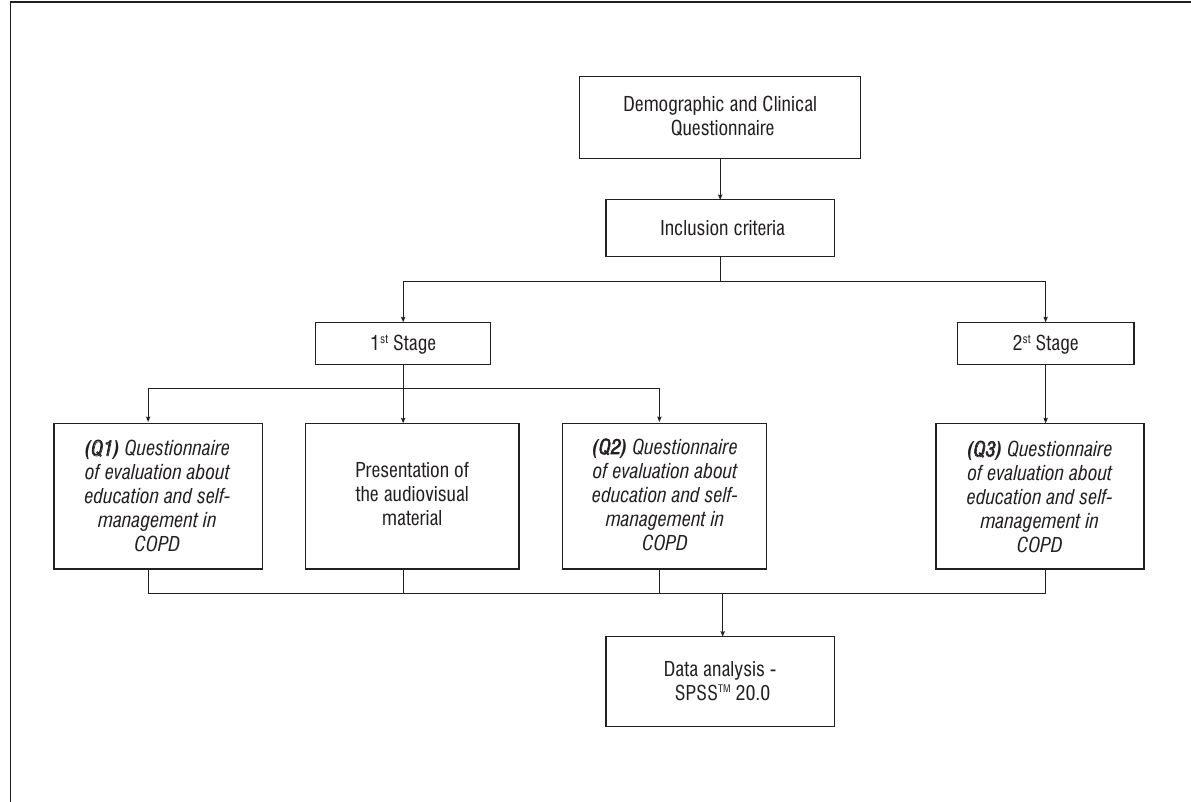
Figure 1 - Flow diagram to methodological stages of the research